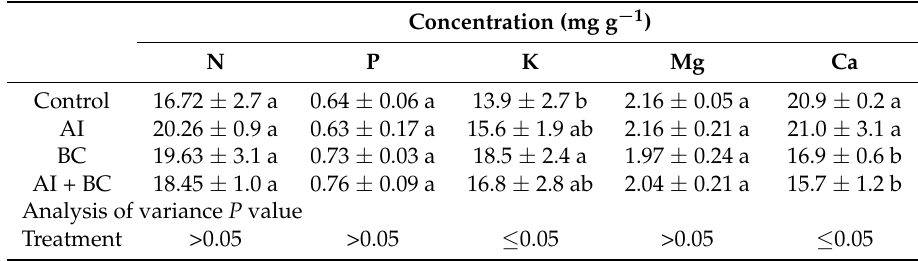
Table 4. Effect of aerated irrigation (AI) and/or biochar (BC) on tissue ion concentration of komatsuna. Values are mean ± standard deviation ( n = 3). Means followed by the same letters are not significantly different at the P ≤ 5% level by the LSD test.